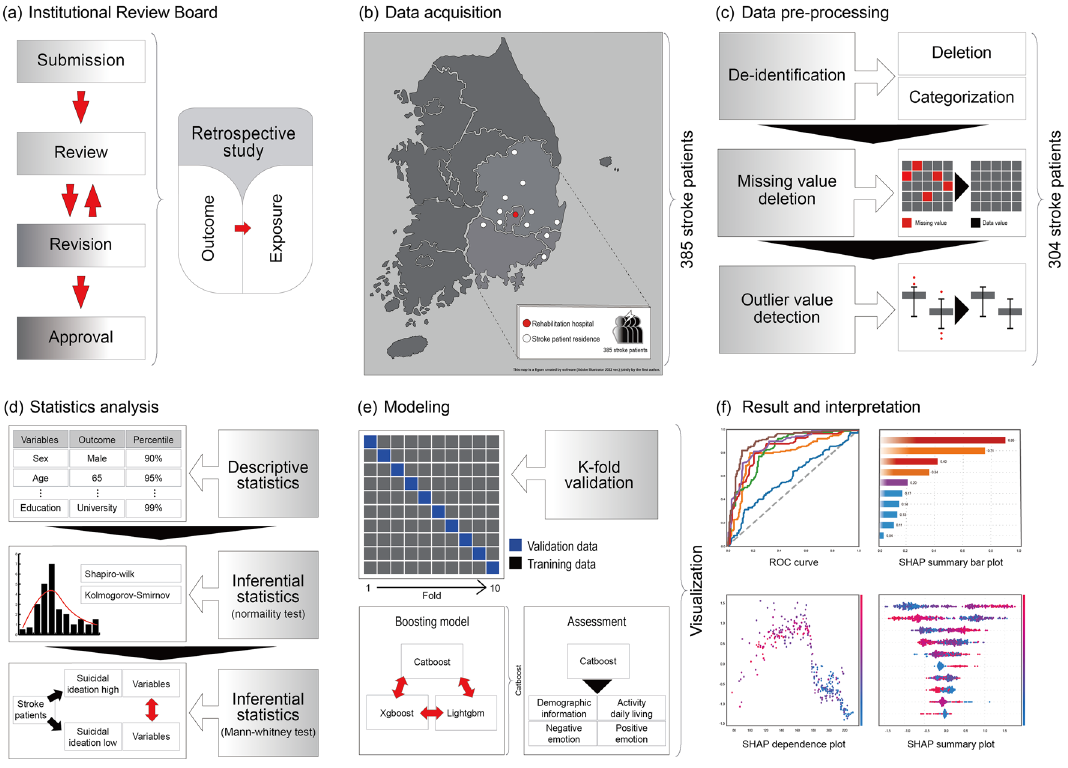
Figure 1. Stroke suicidal ideation prediction